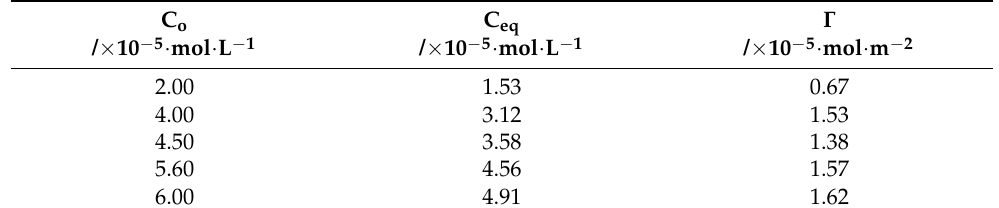
Table 9. Initial concentration, C o , equilibrium concentration, C eq , and surface concentration, Γ , for the adsorption of zinc onto calcite crystals in its saturated solutions in the presence of 5 mL of